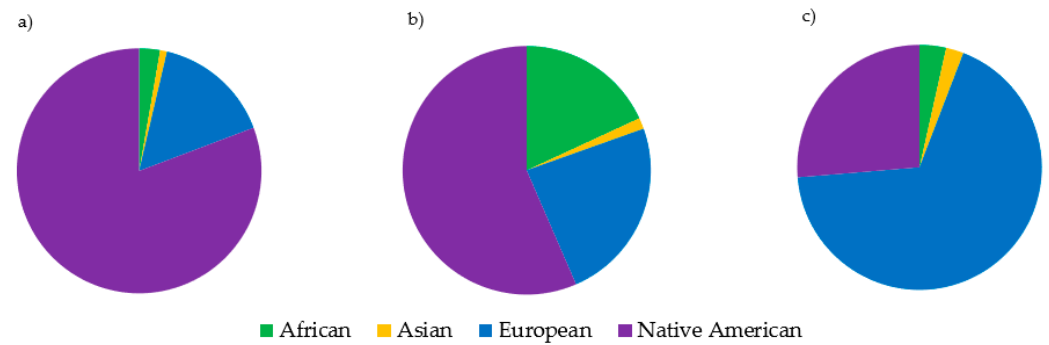
Figure 6. Mitochondrial DNA ancestry proportions in ( a ) the Analytical Genetic Testing Center in Colorado (AGTC-CO) Hispanic (COHS), ( b ) the National Institute of Standards and Technology (NIST) Hispanic (NTHS), and ( c ) the Department of Defense Serum Repository (DoDSR) Native American (DSNA) datasets. Ancestry was classified on a continental level based on the assigned mitochondrial DNA haplogroup.